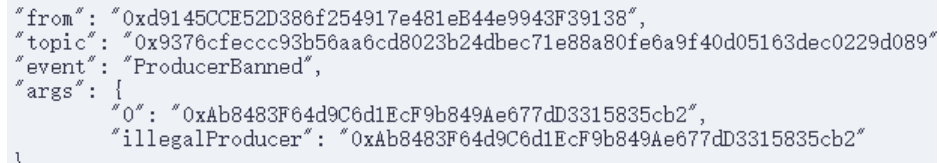
Figure A2. Successful execution of UserExists Function.